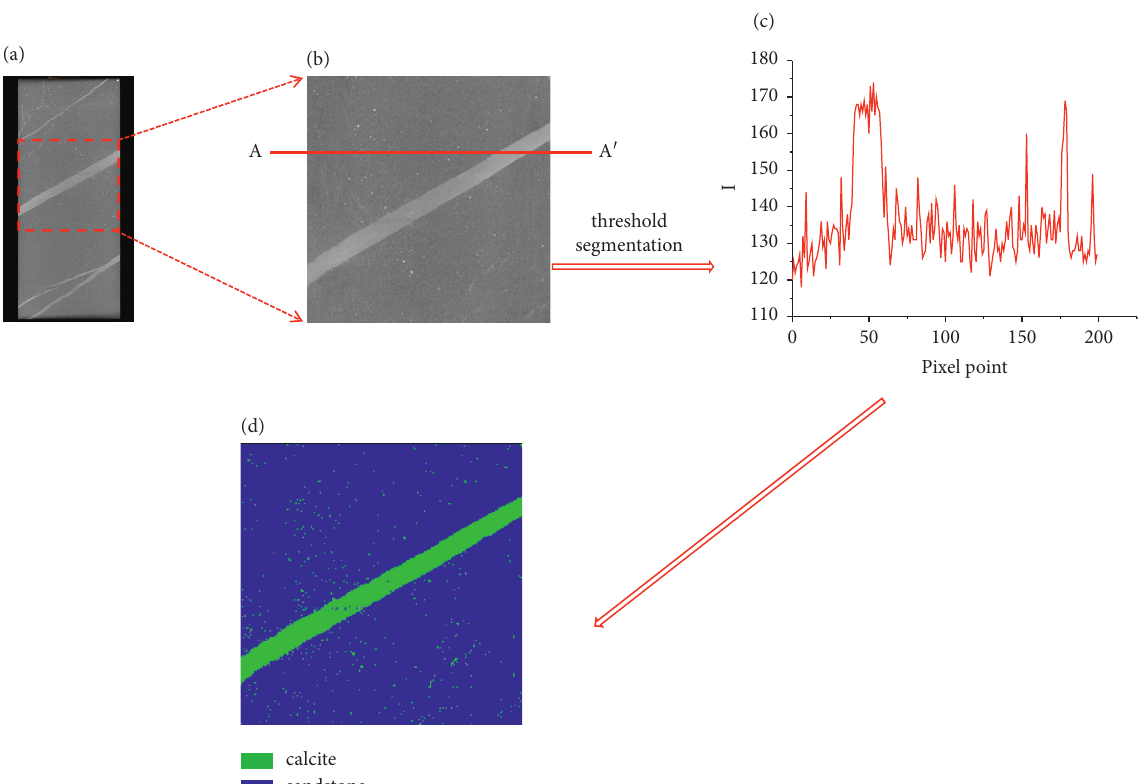
Figure 3: Digital image processing of jointed sandstone. (a) CTslice, (b) scan line AA ′ , (c) variation along I scan line AA ′ , and (d) threshold- segmentation characterization image of